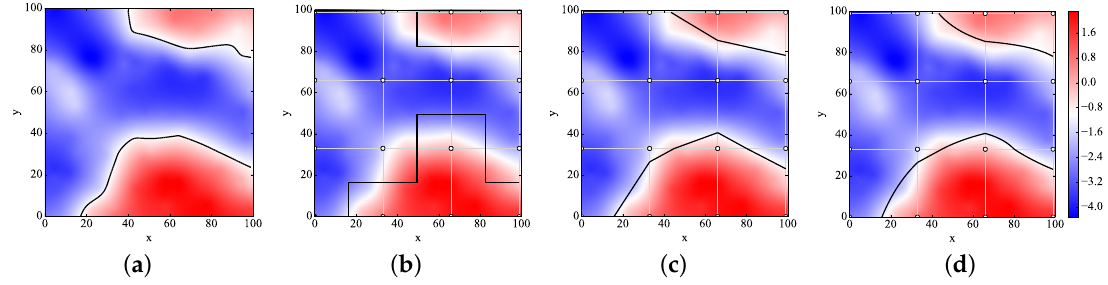
Figure 12. The real boundary and the boundaries generated by the three mentioned algorithms in ROI when n = 3 in the artificially-constructed environment data experiment. ( a ) The real boundary. ( b ) The boundaries by the NN algorithm. ( c ) The boundaries by the MS algorithm. ( d ) The boundaries by the BIB algorithm.